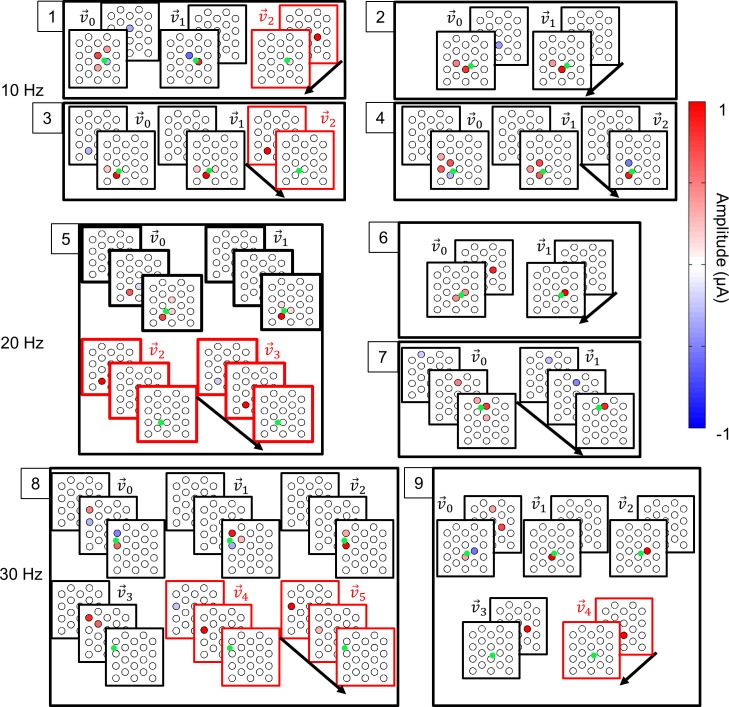
Sample of the diverse varieties of ERFs.Each numbered block represents the ERFs from a single cell. The ERFs in red represent suppressive components. The arrow represents the direction of time for each plot, with stimulus frames separated in time according to the stimulation frequency. Cells 1–4 were stimulated at 10 Hz, cells 5–7 at 20 Hz, and cells 8–9 at 30 Hz. Only significant electrode amplitudes are shown, and all significant electrodes are visible. Stimulating electrodes are separated by 1 mm center-to-center.